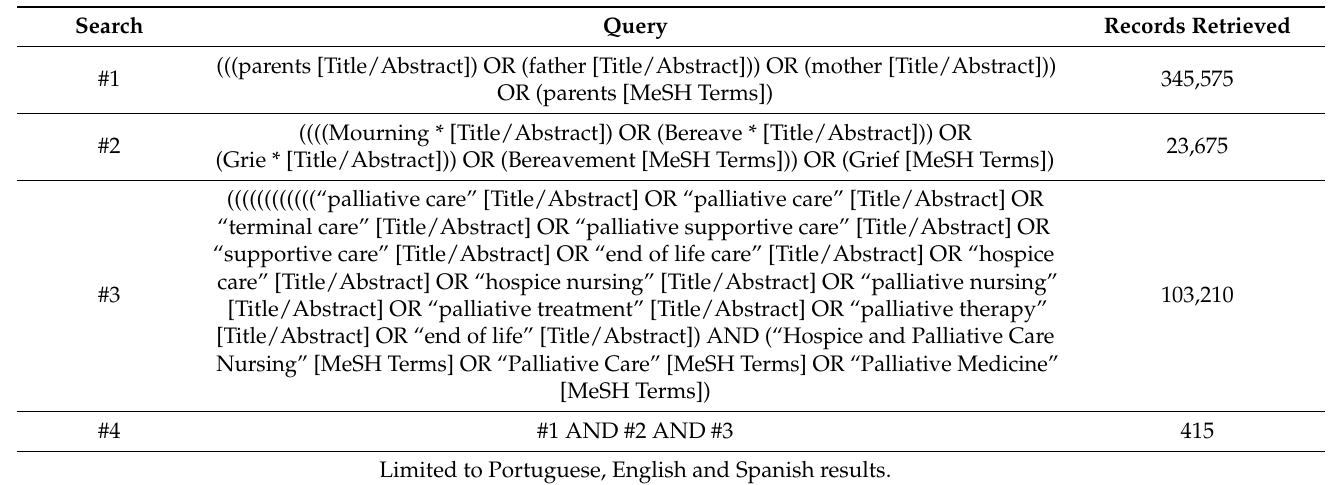
Table 1. Search strategy for MEDLINE (PubMed) conducted on 10 December